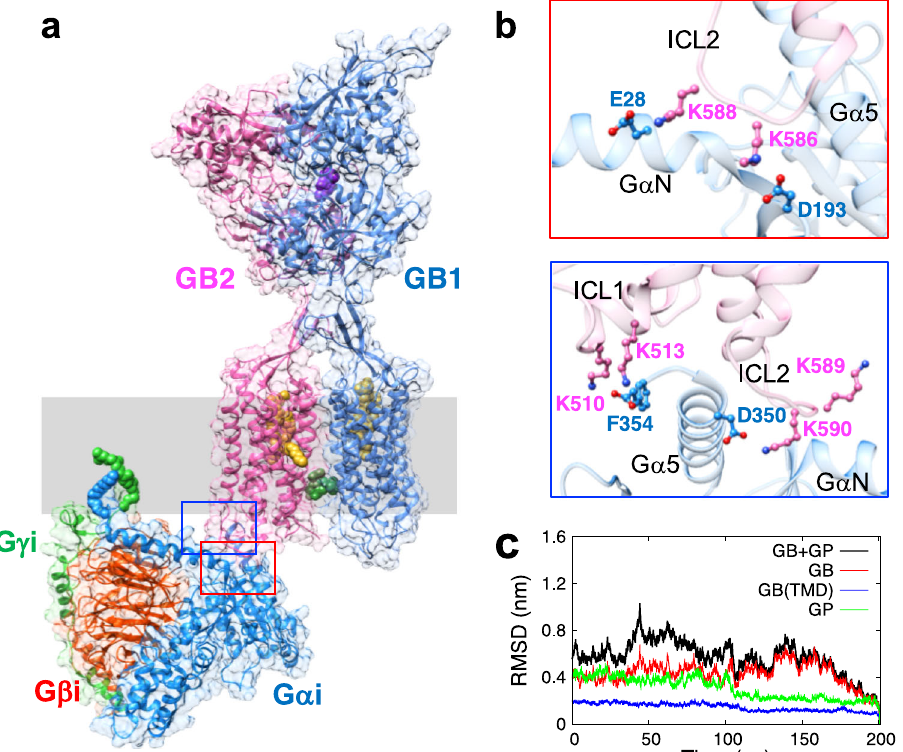
Fig.2|Thestructureoftheagonist-GABA B R-heterotrimericG i Pcomplex.a The agonist-GABA B R-G i P complex exhibits trans-activation in which G i P interacts with GB2, while the agonist binds to the GB1-VFT. b G i P makes key SB interactions [K586ICL2-D193G α , K588ICL2-E28G α N, K590ICL2-D350G α 5, and K510ICL1-